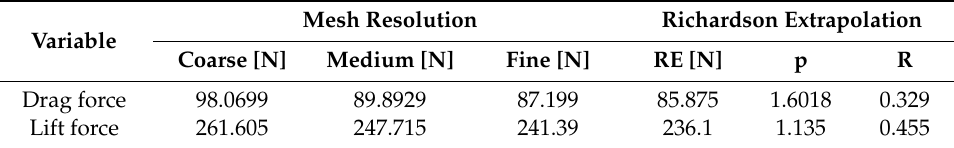
Table 1. Mesh verification for Reynolds-Averaged Navier-Stokes